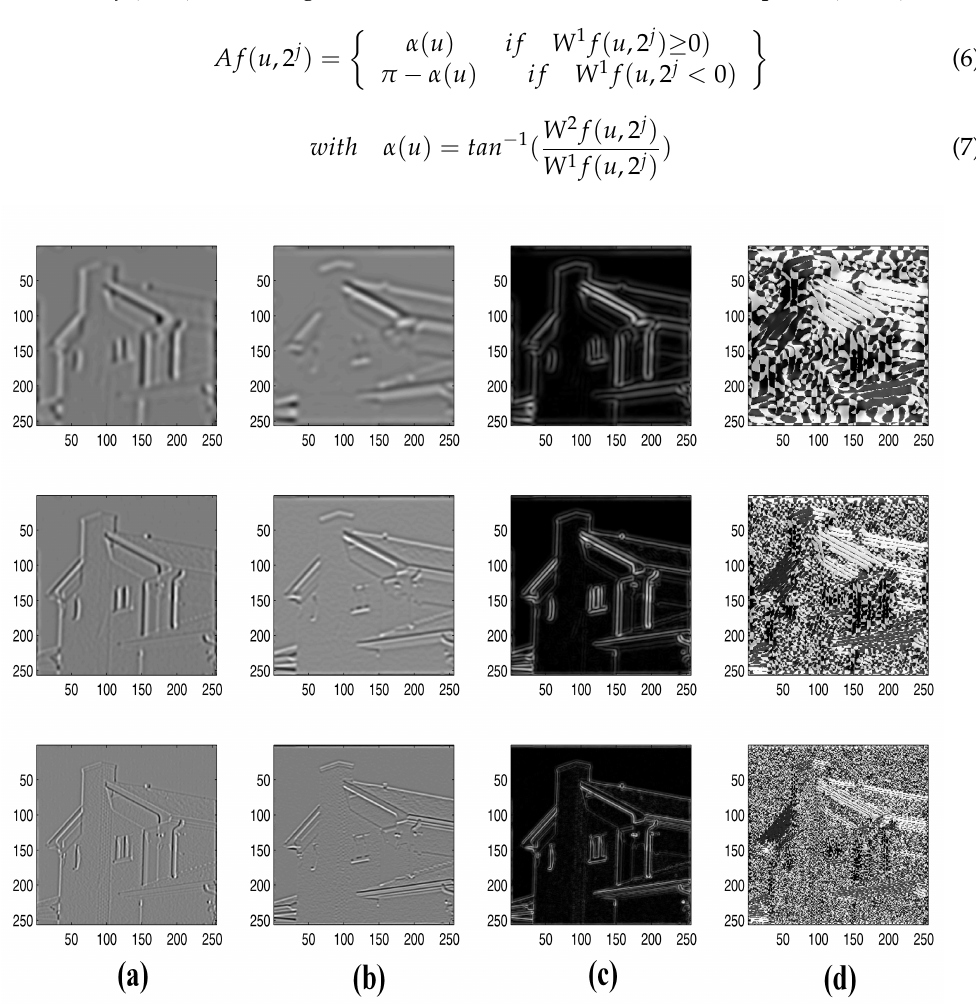
Figure 3. The continuous wavelet transform (CWT)-based multi scale decomposition of the image with θ corresponding to the Gaussian function. ( a ) Images correspond to the gradient image in the vertical direction measuring changes in intensity where as the ( b ) images represent a gradient image in the horizontal direction measuring the horizontal change in intensity. ( c ) Wavelet transform modulus maxima representing significant transitions or edges in the images and ( d ) shows the angle of these